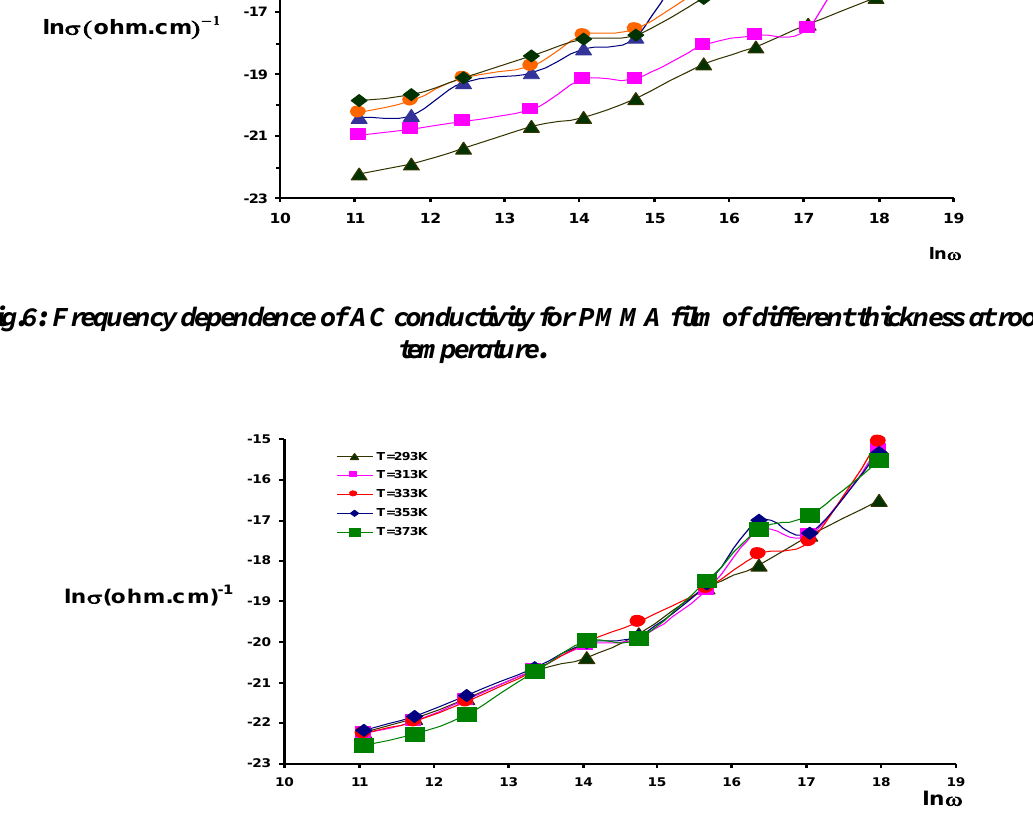
Fig.7: Frequency dependence of A.C conductivity for PMMA film of different